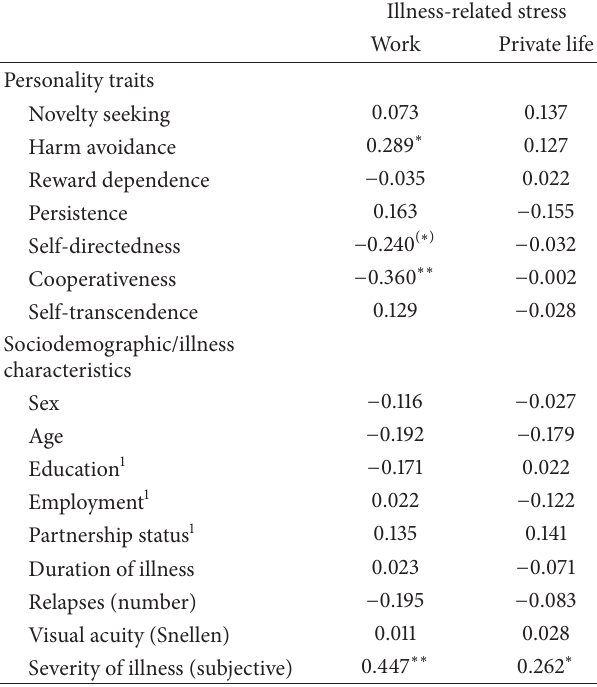
Table 1: Sociodemographic characteristics. Table 2: Spearman’s correlations between personality dimensions, sociodemographic and illness characteristics, and illness-related stress in central serous chorioretinopathy